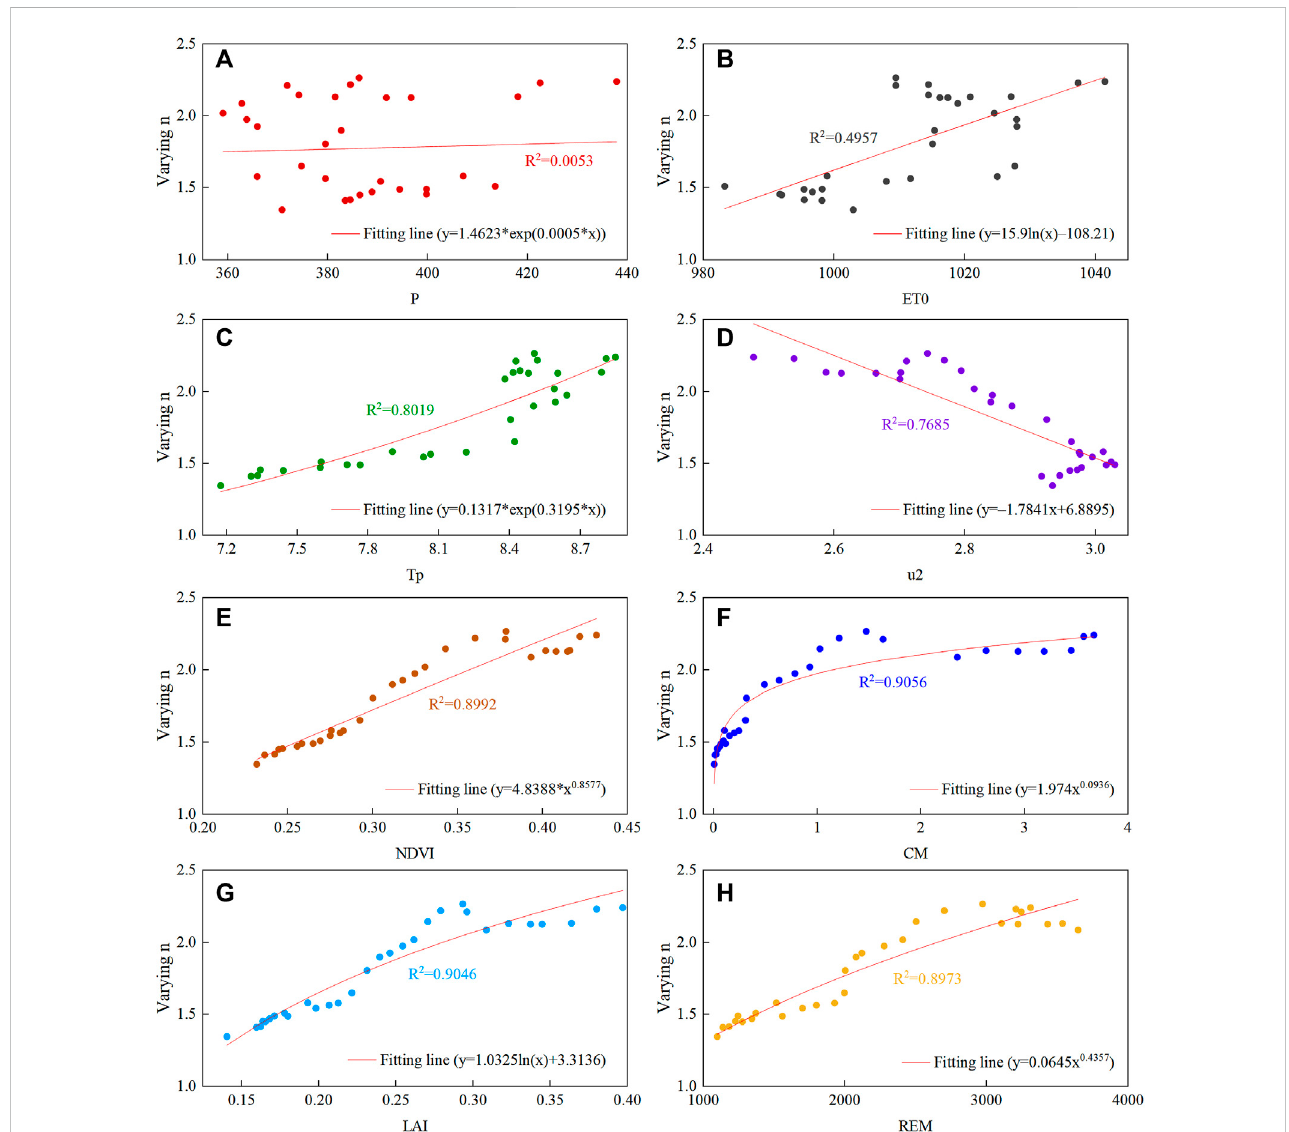
FIGURE 6 Variation of runoff elasticity coef fi cient of each factor (A) p , (B) ET 0 , (C) T p , (D) NDVI, (E) Coal Mining, (F) CM (G) LAI, (H) REM.